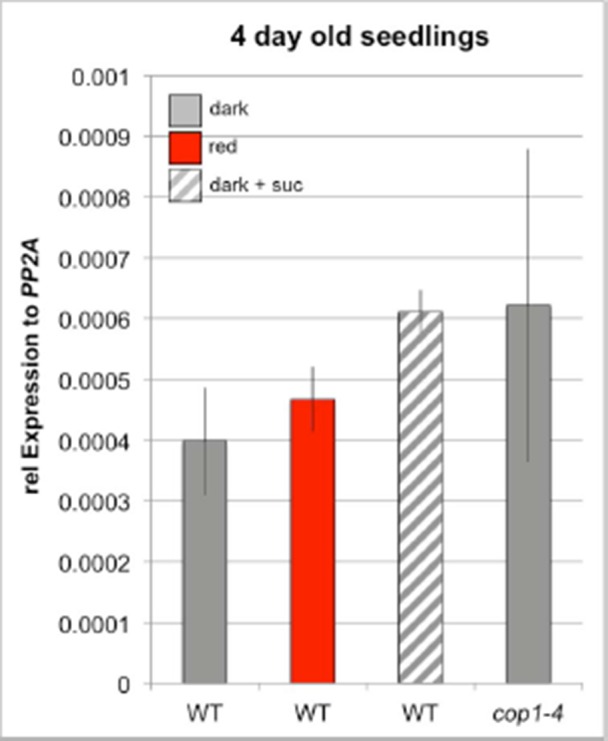
DOI:
http://dx.doi.org/10.7554/eLife.17023.016